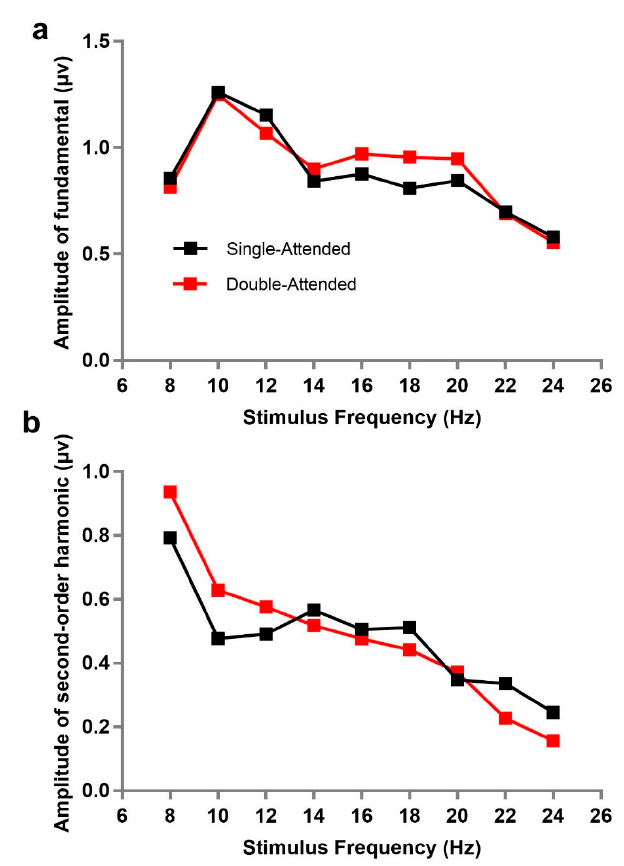
Figure 2. Amplitude change with stimulus frequency under single-attended and double-attended conditions: ( a ) amplitudes of fundamental, and ( b ) amplitudes of second-order harmonic. The horizontal axis shows the flickering frequency of the stimulus and the vertical axis shows the amplitudes corresponding to the stimulus frequency at the fundamental ( a ) and the second-order harmonic ( b ). Single-attended refers to only one stimulus flashing in the central field of vision (as a comparison); double-attended means the target stimulus (attended) was paid attention to while another flashing stimulus was presented simultaneously.